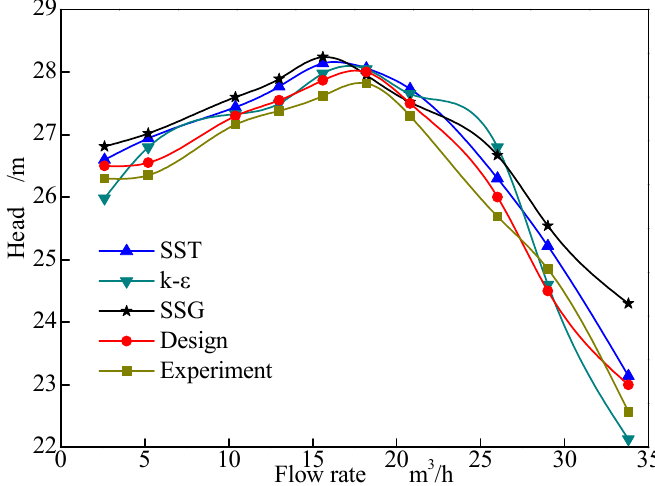
Figure 5. Turbulence models validation.